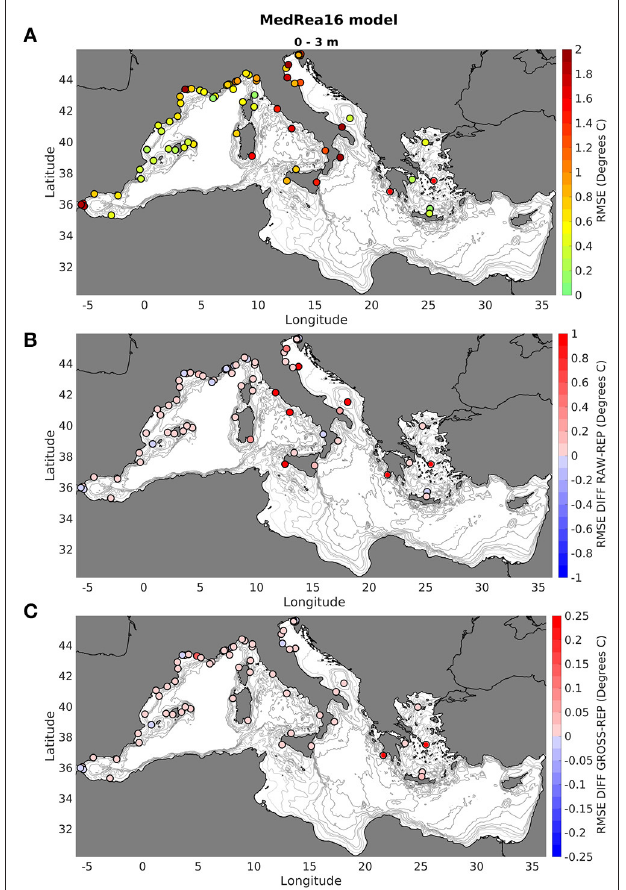
FIGURE 12 | Temperature RMSE of MedRea16 model computed at MED-NRT mooring locations over the time period 2013–2018 in the surface layer 0–3 m: (A) RMSE obtained after mooring data reprocessing (gross QC and recursive statistical QC); (B) differences between RMSE using raw data and reprocessed data; (C) differences between RMSE using data after gross QC as reprocessed